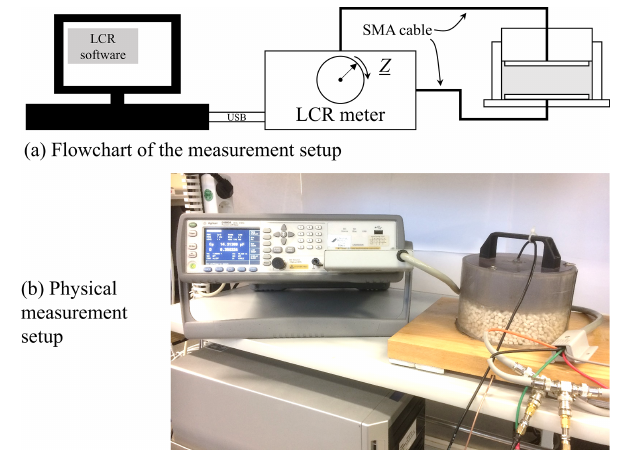
Figure 3. Measurement setup. (a) System architecture. (b) Physical realization.